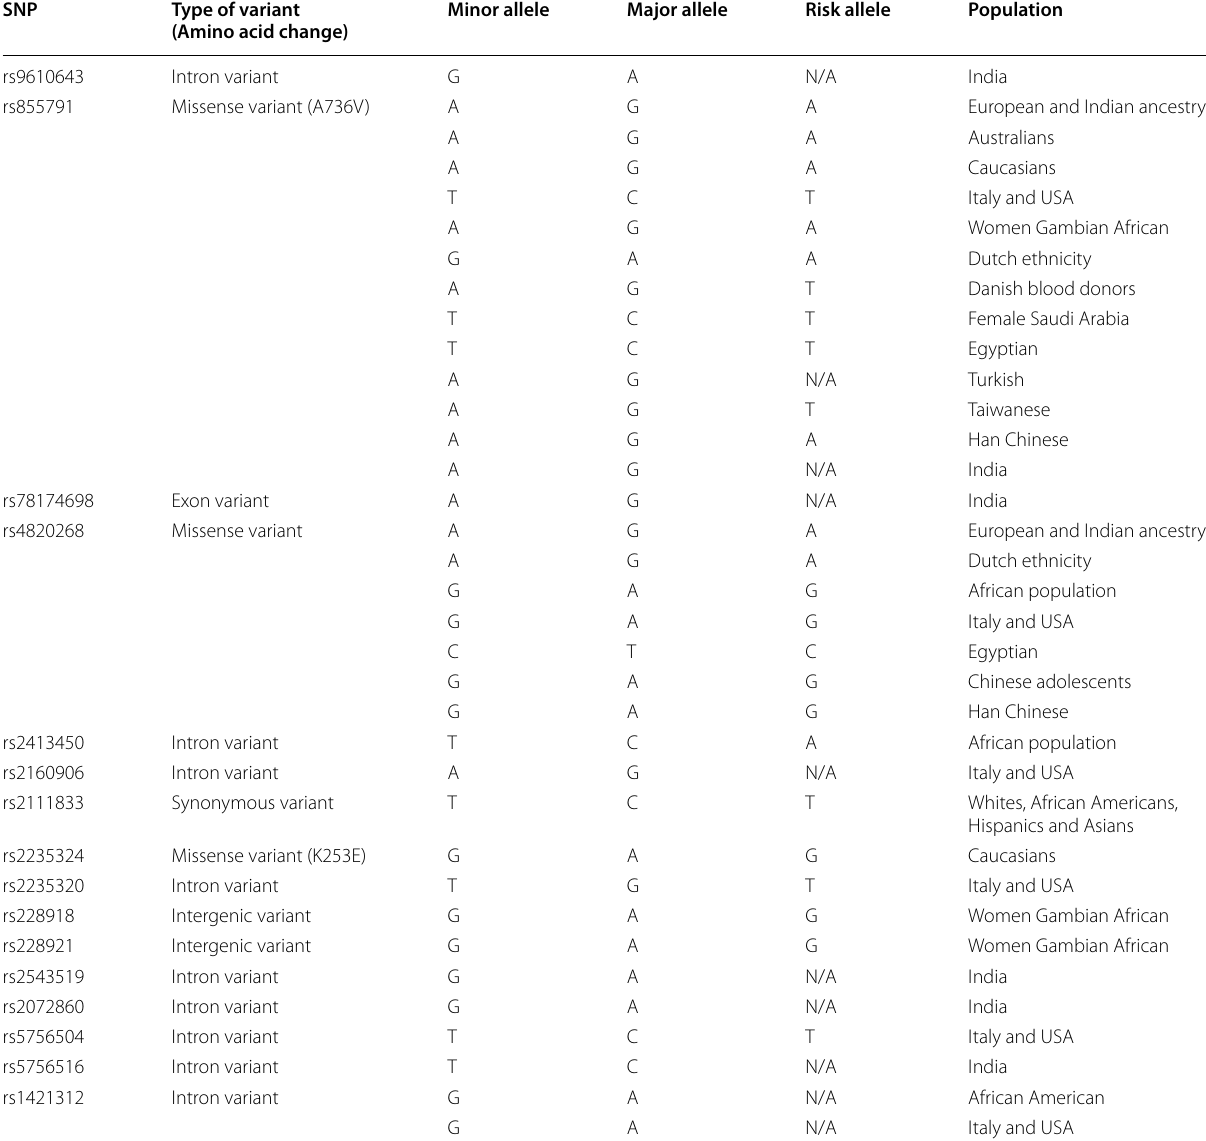
Table 2 Risk allele of TMPRSS6 gene polymorphism across global population associated with iron and blood parameters imbalance. (Location: Line 474)